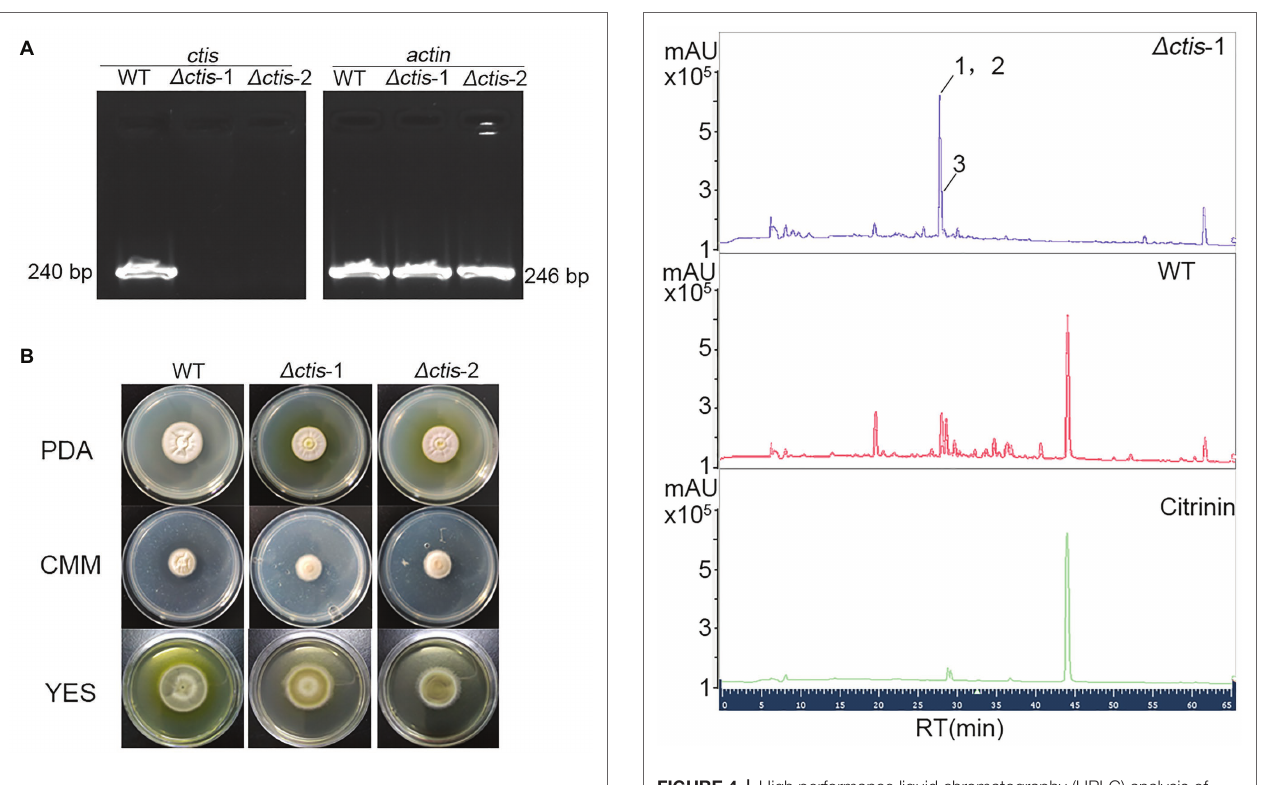
FIGURE 3 | Deletion of citS gene in P2648. (A) RT-PCR verification of gene deletion, the transcripts of actin gene were used as the control; (B) Conidia of Δ cits and wild-type (WT) were inoculated on the PDA, CMM, and YES plates, culturing at 30 ° C for 7 days.